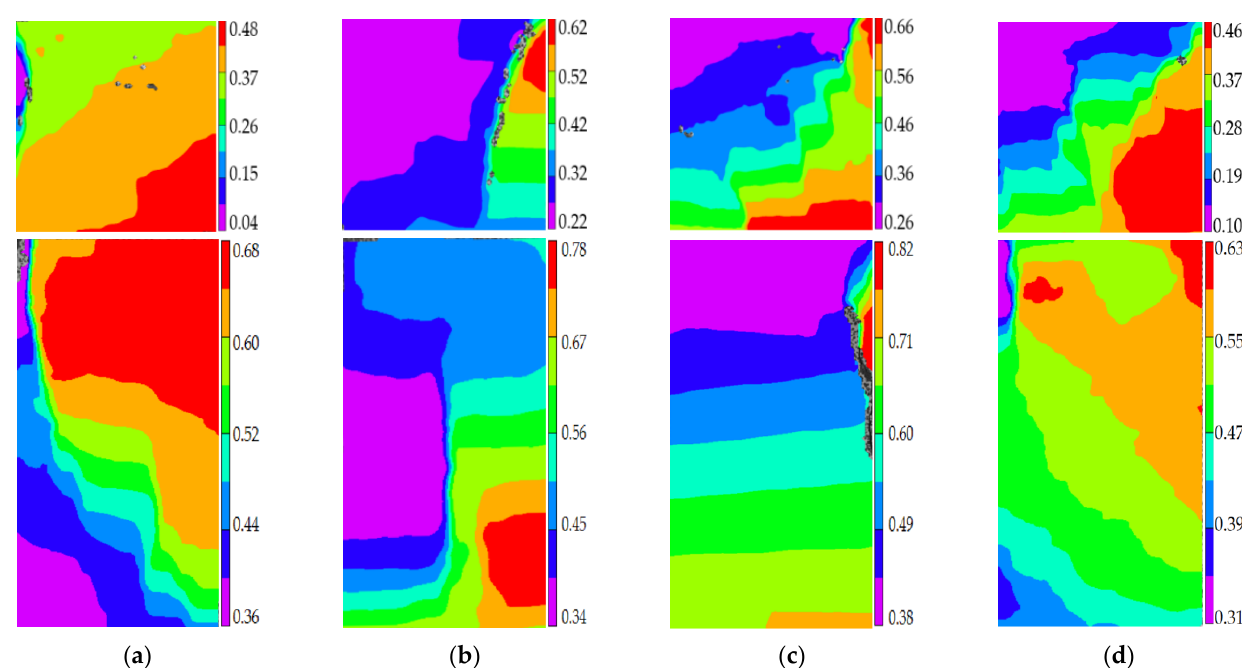
Figure 17. The horizontal strain cloud diagram of concrete with different coarse aggregate volume fraction at the completely failure state, ( a ) 0%, ( b ) 20%, ( c ) 40%, ( d ) 60%.